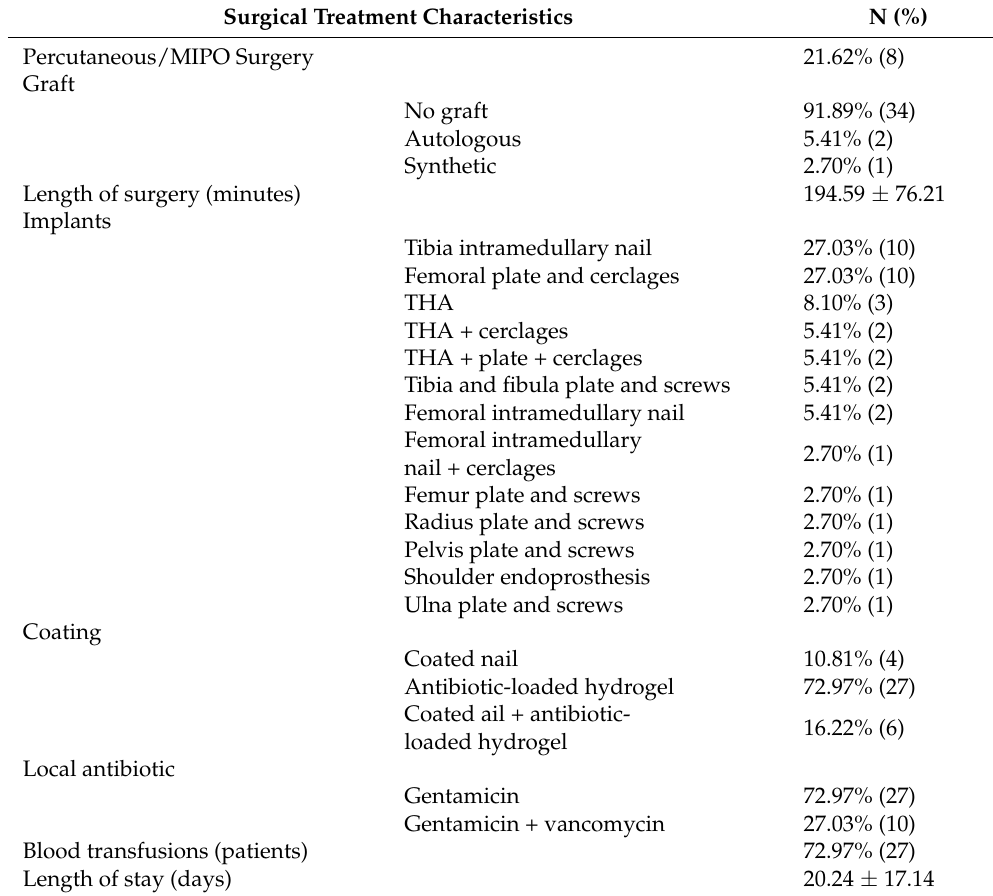
Table 3. Surgical Treatment Characteristics. THA: Total Hip Artroplasty. Surgical Treatment